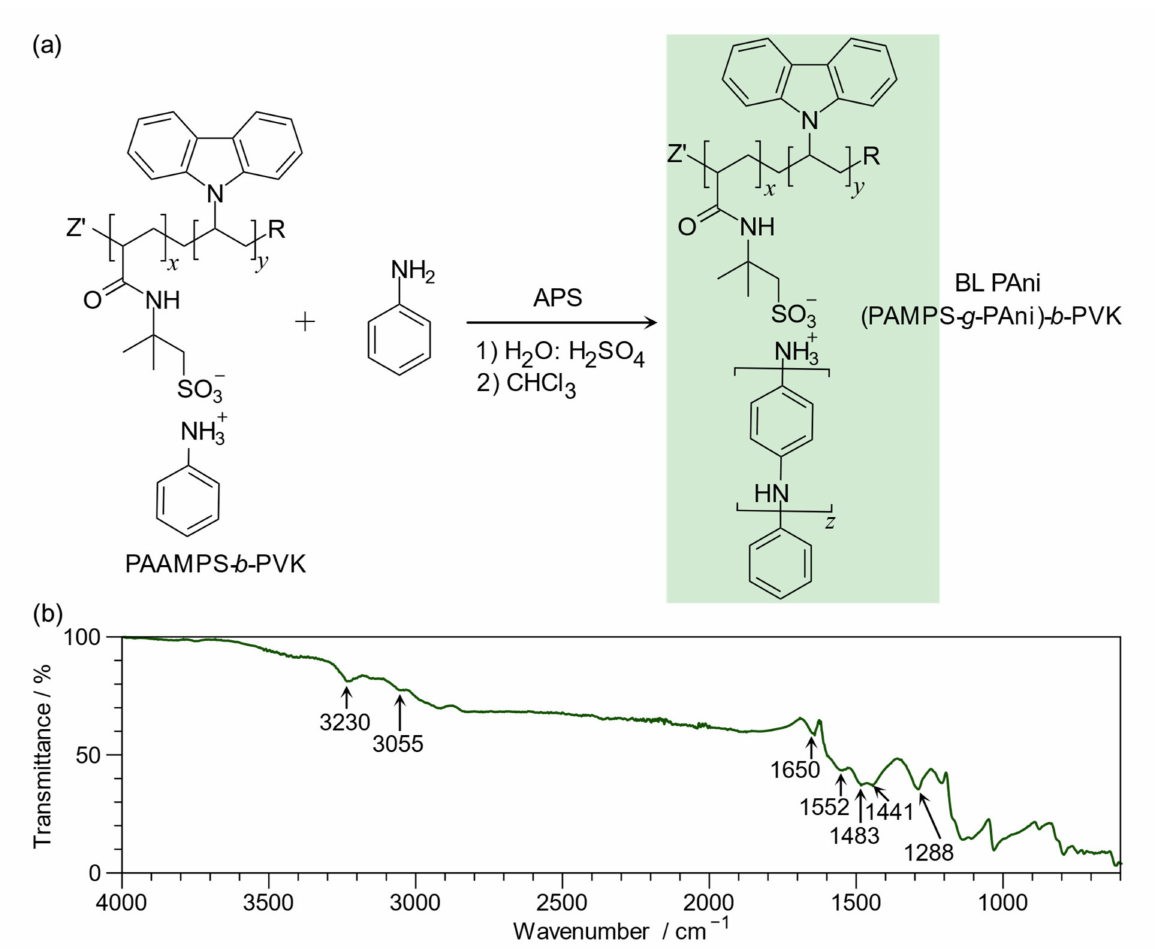
Figure 4. ( a ) Interfacial oxidative polymerization of aniline (Ani); ( b ) FT-IR spectrum of poly(2- acrylamide-2-methyl-1-propanesulfonate- graft -polyaniline)- block -poly( N -vinylcarbazole) (BL